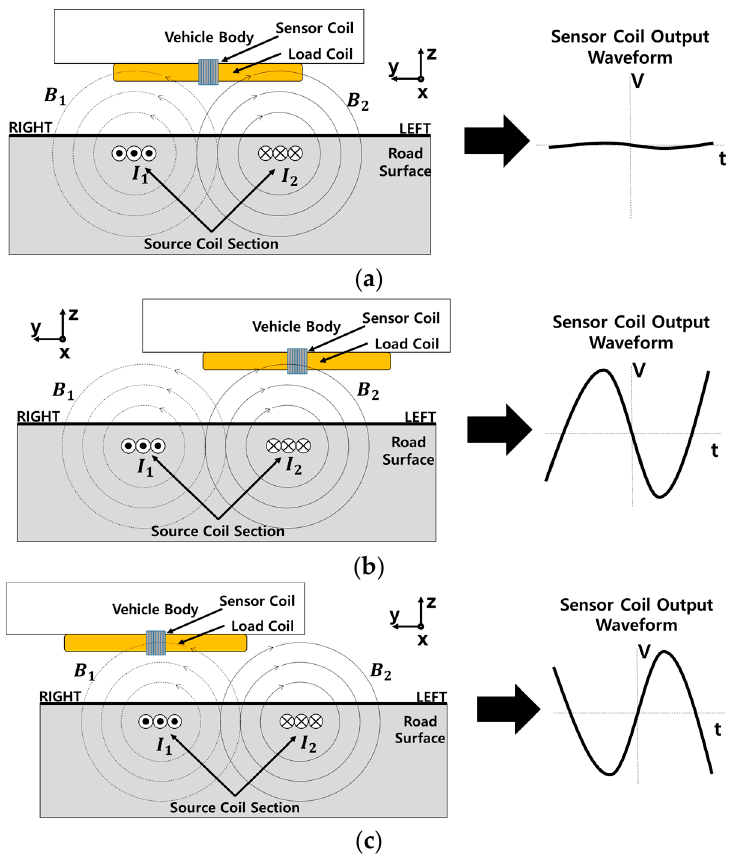
Figure 9. The resulting voltage waveform of the sensor coil in different positions ( a ) when the load coil is aligned with the source coil (origin point); ( b ) when the load coil is misaligned towards the left, and ( c ) when the load coil is misaligned to the right.